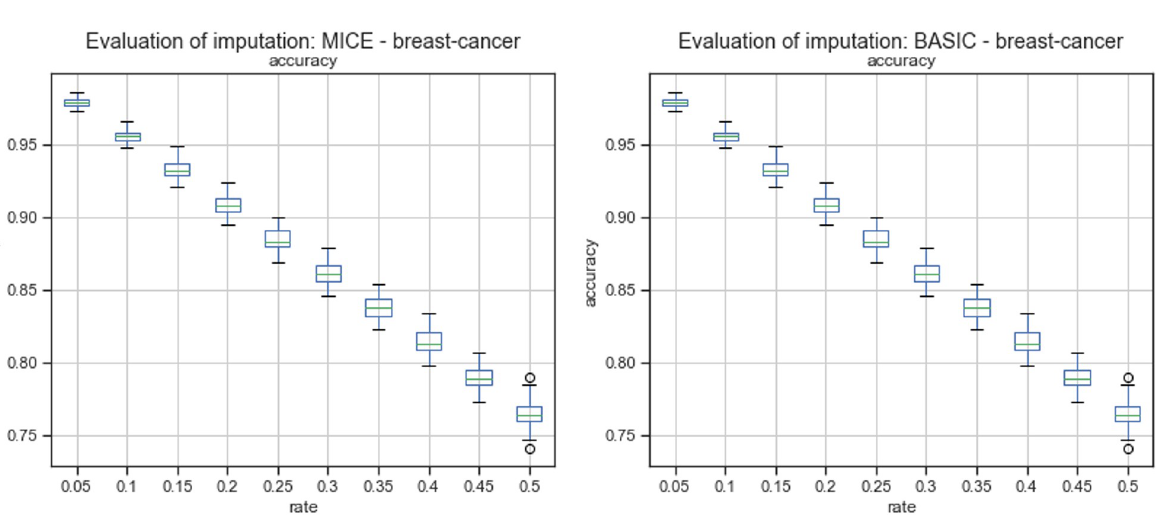
Fig 2. Accuracy of imputations by MICE and